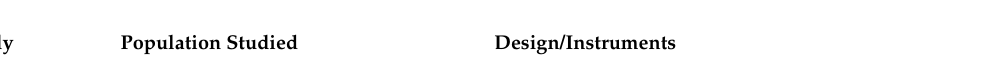
Table 1. Summary of included